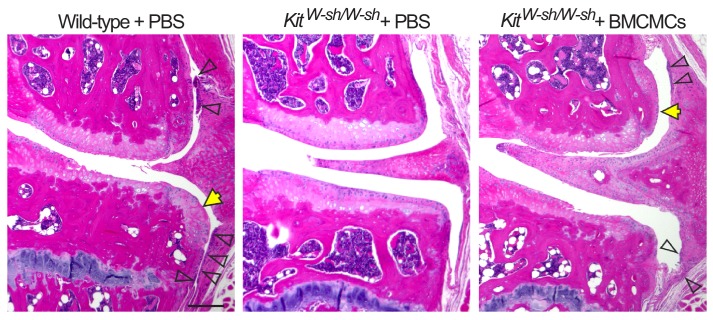
Genetic deficiency of mast cells reduces synovitis and osteophyte formation following DMM.Representative H&E-stained knee joint of stifle joints from C57BL/6J mast cell-sufficient mice (wild-type + PBS), mast cell-deficient mice (KitW-sh/W-sh + PBS), and mast cell-deficient mice engrafted with BMCMCs (KitW-sh/W-sh + BMCMCs) 20 weeks after DMM surgery. Open arrows indicate synovial inflammation or synovial thickening, yellow arrow indicates osteophyte. Scale bars, 200μm. *P ≤0.05 by Student’s t test.